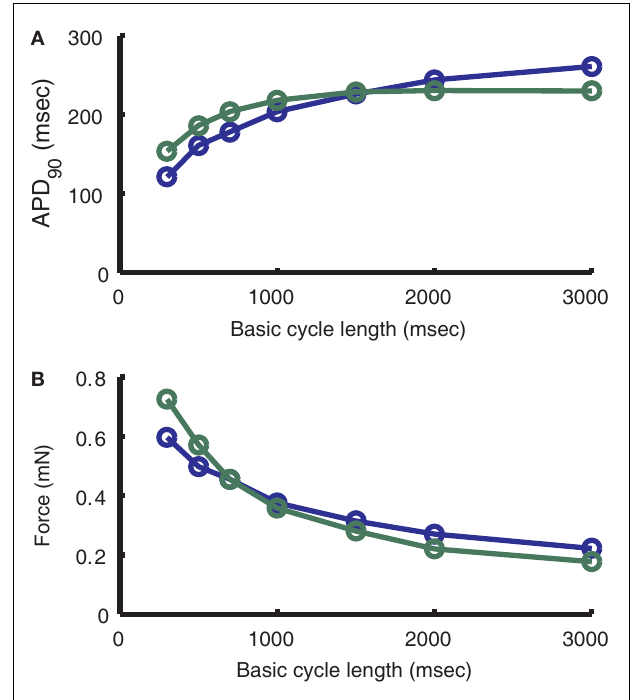
FIGURE 11 | Frequency-dependence ofAPD and Force. (A) Comparison of model (blue) dependence of APD on frequency to that of Szigligeti et al. (1996; green). (B) Comparison of model (blue) dependence of force on frequency to that of Szigligeti et al. (1996; green). See Section “Frequency-Dependence of APD and ECC” of the text for conversion of normalized model output to force